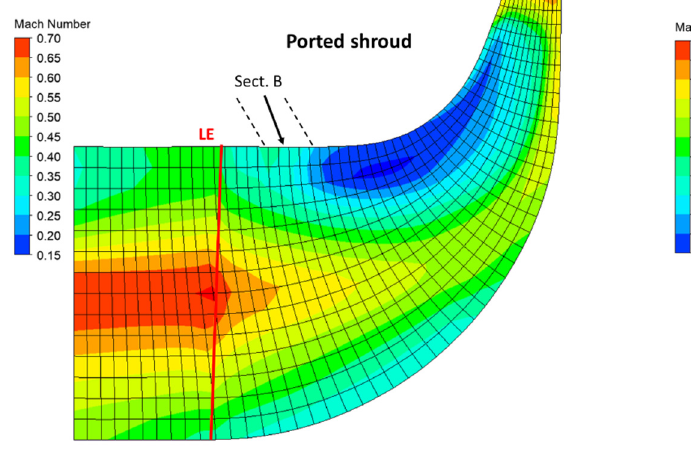
Figure 12. Comparison of the hub-to-shroud distribution of the meridional velocity at the leading edge between the configurations with ported shroud and baseline, at near surge condition OP2.